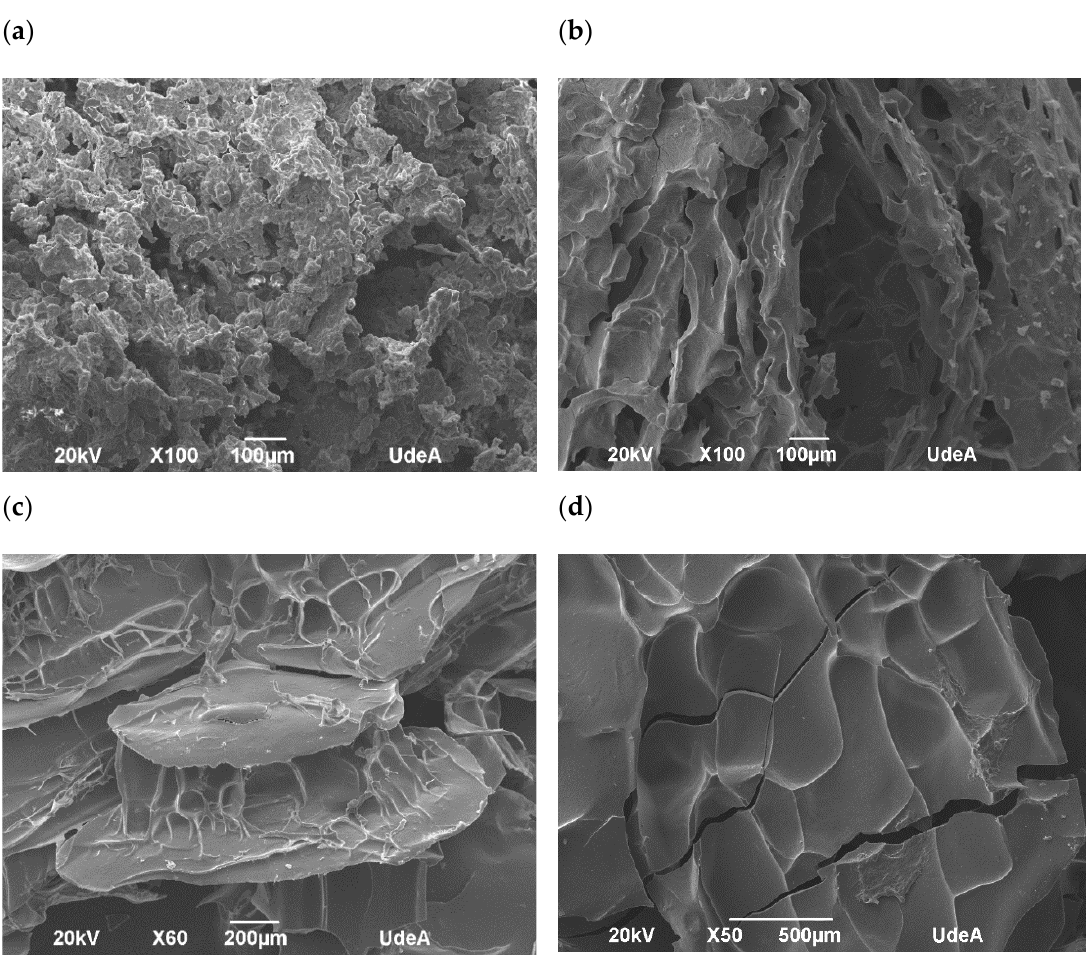
Figure 4. Scanning electron microphotographs of encapsulated annatto extract. ( a ) Encapsulated extract with lentil proteins, ( b ) encapsulated extract with quinoa proteins, ( c ) encapsulated extract with sodium caseinate, and ( d ) encapsulated extract with soy proteins.